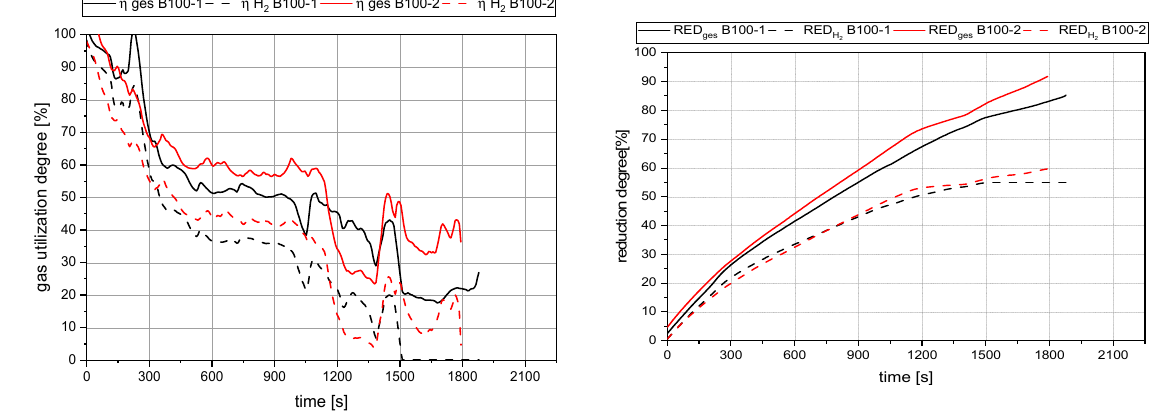
Figure 16. Gas utilization and reduction degree at 100 g batch and no charged mass.